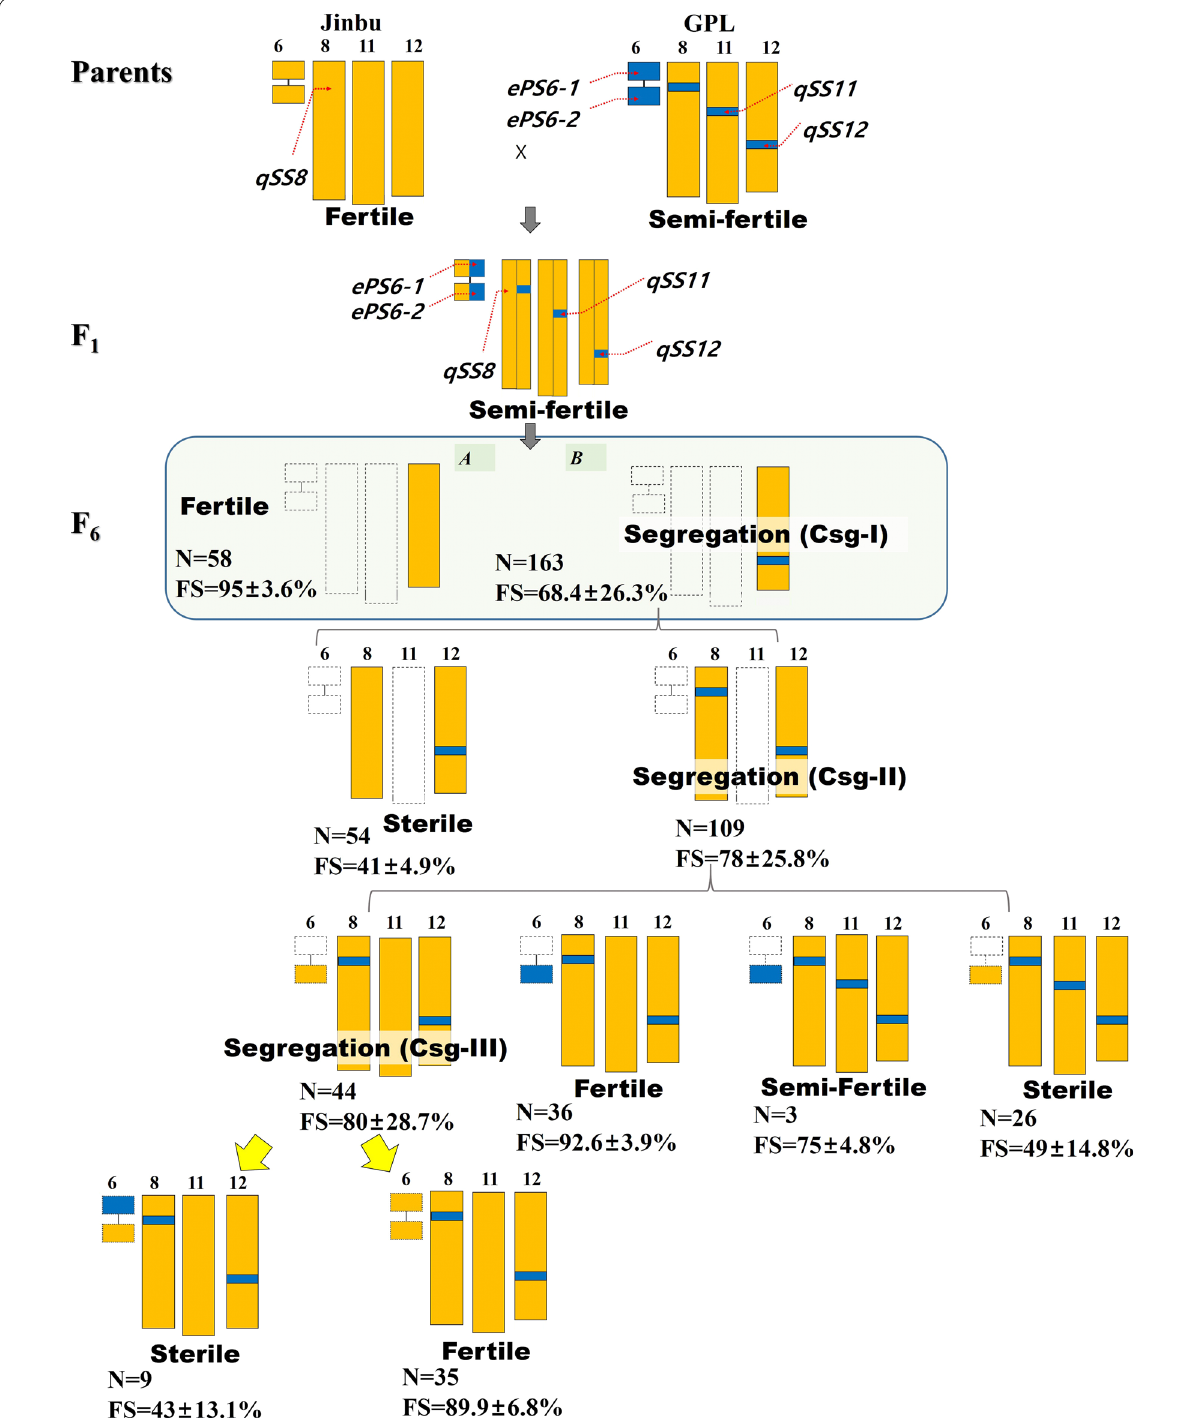
Fig. 3 Genetic model for spikelet fertility explained by QTL combinations. The parent and F 1 plants did not show phenomena related to spikelet sterility. The near‑isogenic population showing the segregation of fertility in the F 2 generation advanced six more generations. The orange plot indicates the allele of P1 (Jinbu), and the blue plot indicates P2 (GPL). The white rectangle of the dotted line indicates that it includes both alleles from the parents. Three cases (Csg‑I, Csg‑II, and Csg‑III) for the segregation of SF were observed according to the combinations. N is number of plants, and FS is the fertility